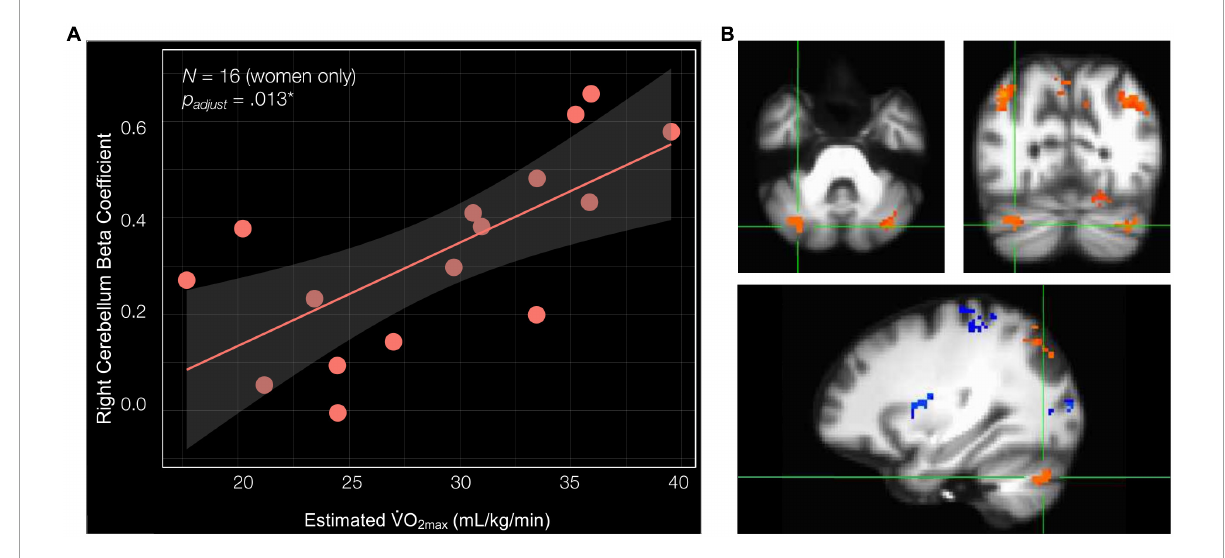
FIGURE4 Cardiorespiratory fitness is associated with right cerebellum lobule VIIa Crus I and II beta coefficient in women. (A) Estimated ˙VO 2 max is significantly associated with the beta coefficient of the cluster in the right cerebellum lobule VIIa Crus I and II (estimated ˙VO 2max — β = 0.023, SE = 0.006, t [13] = 3.881, p = 0.002**, p adjust for ROIs (7) = 0.013*, delta-R 2 = 0.532). (B) Significant cluster comprised of the right cerebellum lobule VIIa Crus I and II shown in three planes, listed in order of top left, top right, and bottom: axial (left = right hemisphere), coronal (left = right hemisphere), and sagittal (left =